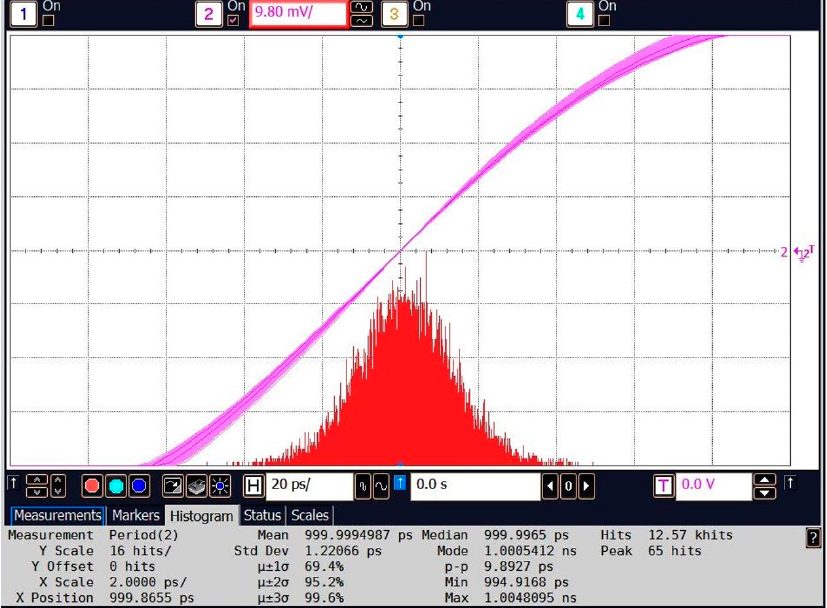
Figure 10. Measured jitter histogram at 1 GHz.